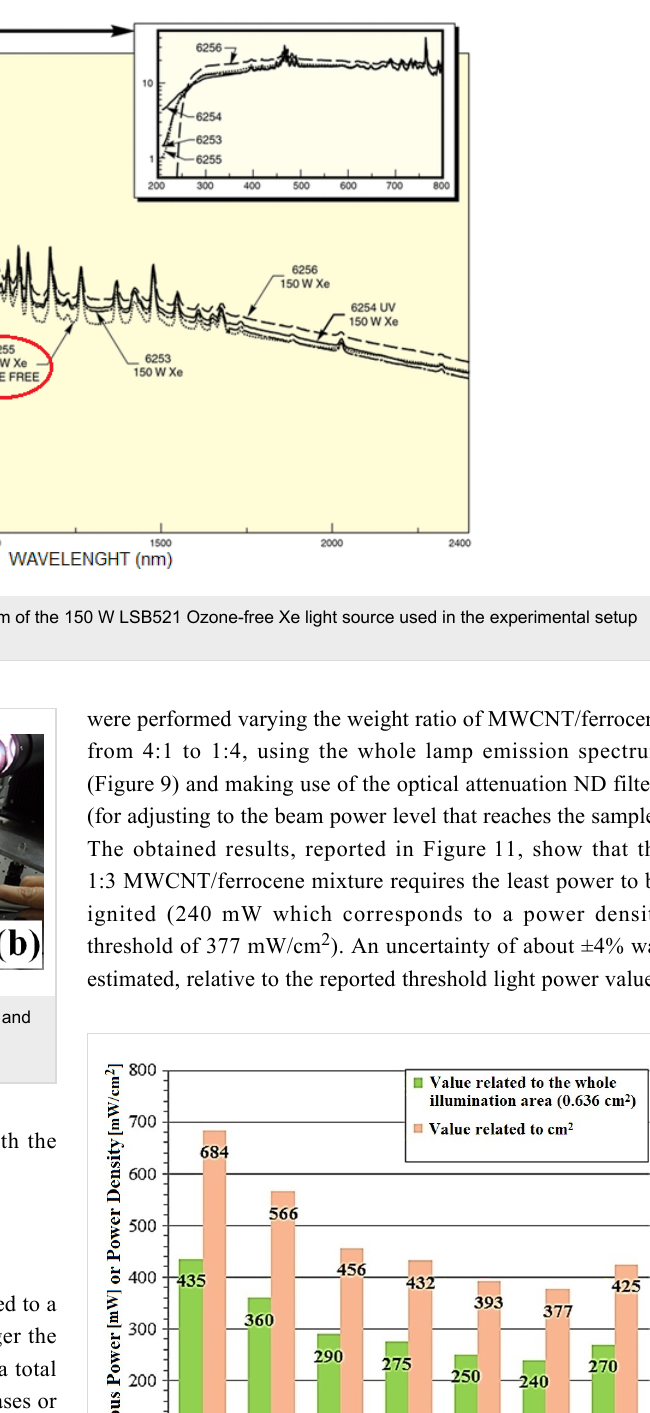
Figure 11: Light power thresholds for ignition of MWCNT/ferrocene mixtures found by varying the weight